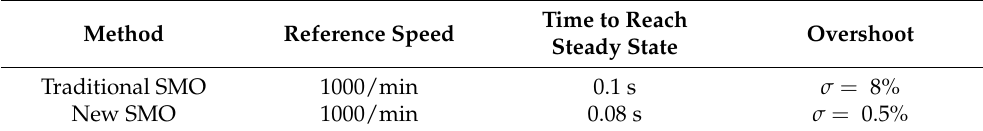
Table 6. The comparative experimental results of